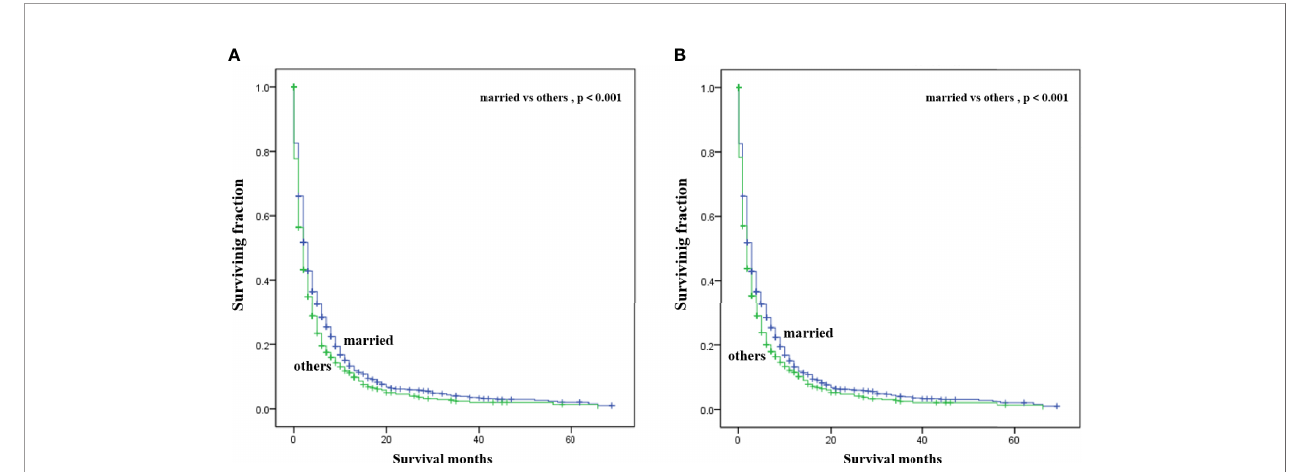
FIGURE 7 | Kaplan-Meier survival curves for estimating OS (A) and CSS (B) in patients with PCBM based on marital